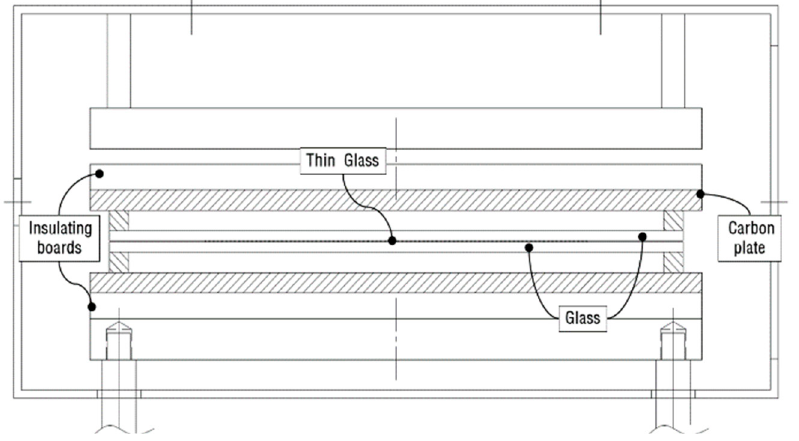
Figure 12. Schematic illustration of the experimental setup used for glass edge-sealing.